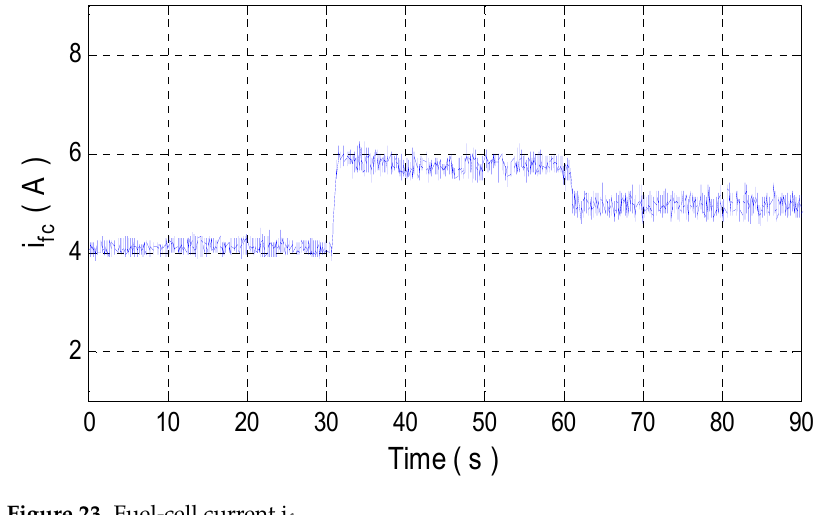
Figure 23. Fuel ‐ cell current i fc .